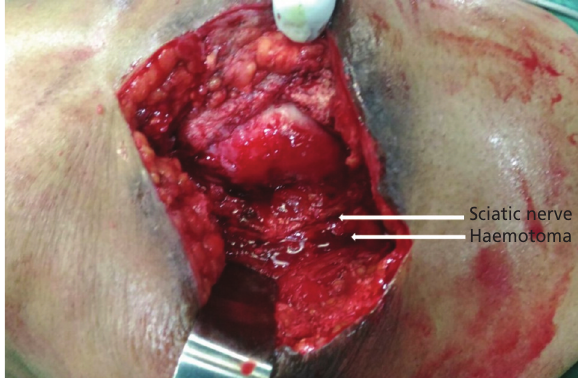
Intraoperative image showing haematoma around the Fig. 2: sciatic nerve.